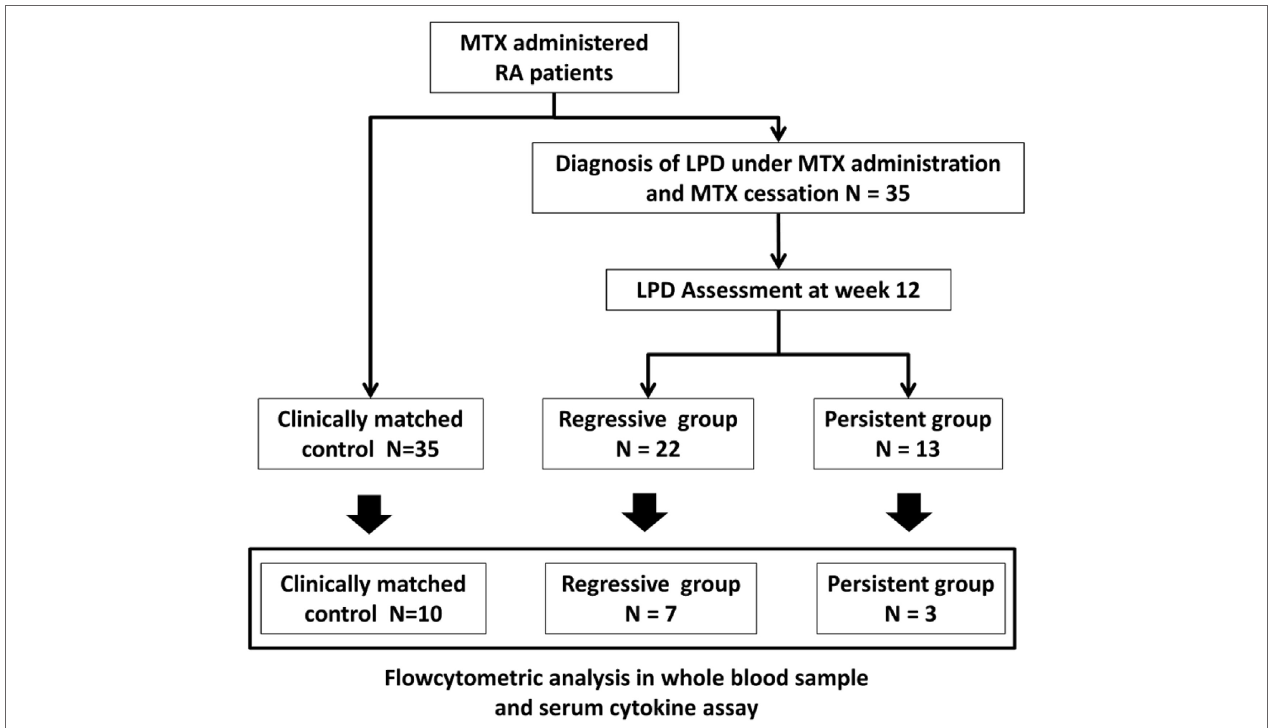
Figure 1 | Classification of LPD patients and patient flow. Twenty-two and 13 patients were divided into the regressive and persistent groups, respectively, according to LPD regression assessment at week 12. Control patients were age-, sex-, rheumatoid arthritis duration-, and MTX dose-matched with LPD patients ( N = 35). Flow cytometric analysis of whole blood sample and cytokine analysis of serum sample were conducted for 10 patients from the control group, 7 patients from the regressive group, and 3 patients from the persistent group. MTX, methotrexate; LPD, lymphoproliferative disorder.